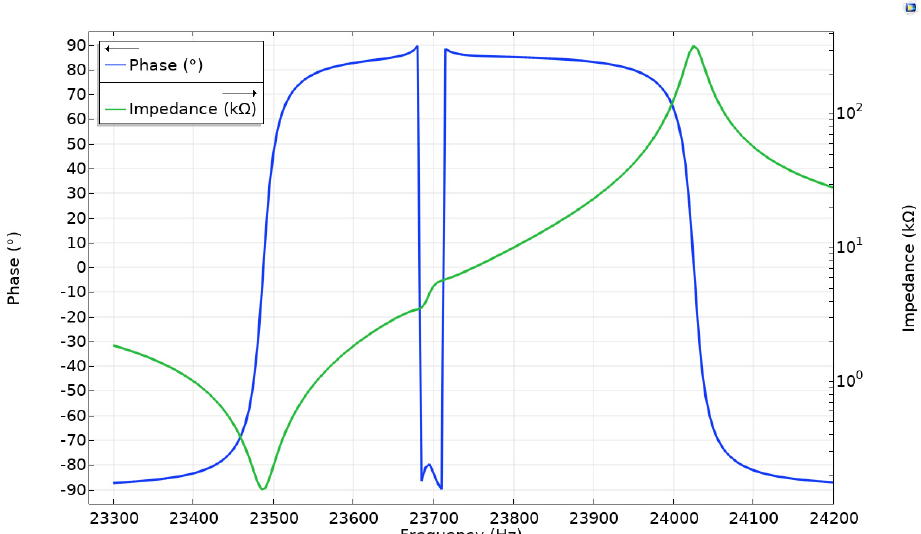
Figure 7. Impedance and phase frequency characteristics of the platform.